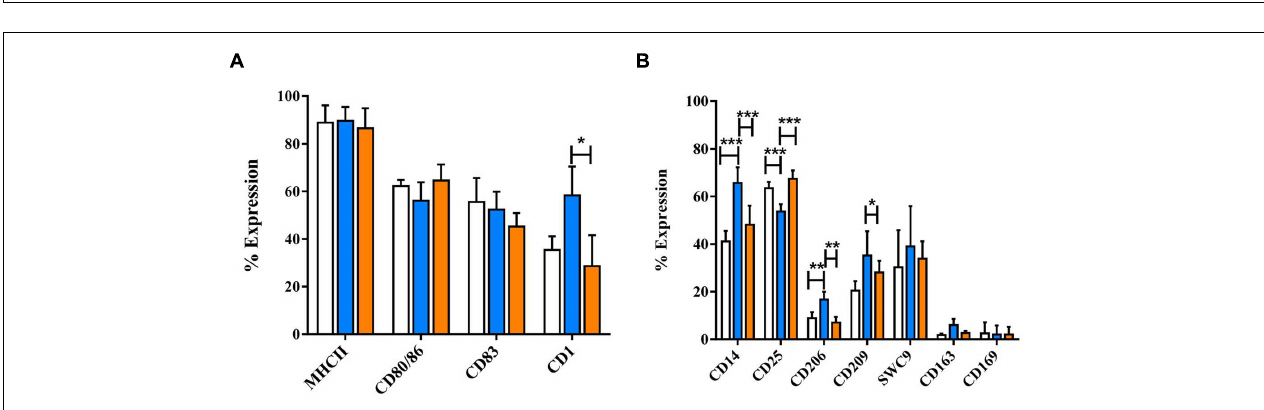
FIGURE 5 | The effect of maturation cocktail on porcine MoDC. Four-day-old MoDC were treated with a maturation cocktail for 24 h before flow cytometric analysis of surface molecules involved in DC maturation or antigen presentation (A) and other co-stimulatory molecules and lineage markers (B) in untreated iMoDC (white bars) and cytokine maturation cocktail treated (blue bars) MoDCs. Bars show mean percentage of cells expressing each marker + SD. Two-way ANOVA was used to assess significance followed by Bonferroni’s multiple comparison test, ∗∗ p < 0.001.